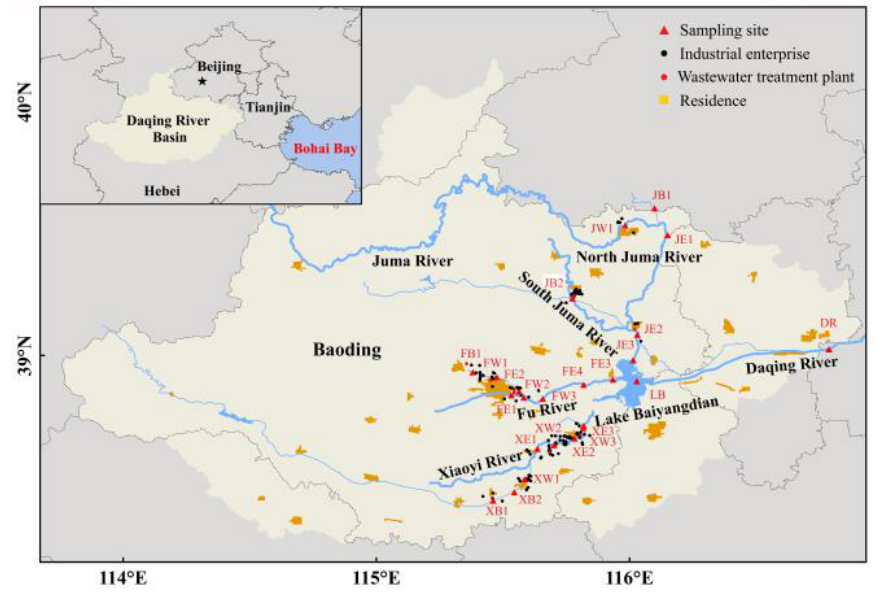
Figure 1. Sampling sites in the Daqing River Basin, including the Juma River (J), the Fu River (F), the Xiaoyi River (X), Lake Baiyangdian (LB), and the Daqing River downstream (DR). Table 1. Discharge concentration limit (mg L − 1 ) of water pollutants specified in the wastewater discharge standard for the Daqing River Basin (DB 13/2795 – 2018).